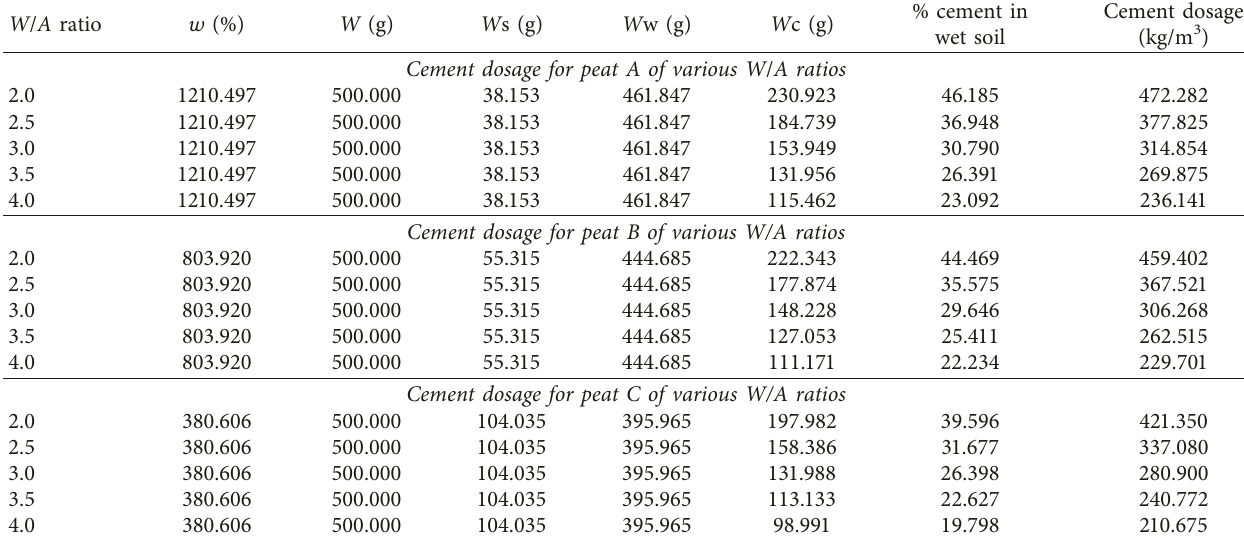
Table 2: Cement dosage for peat A of various W / A ratios.